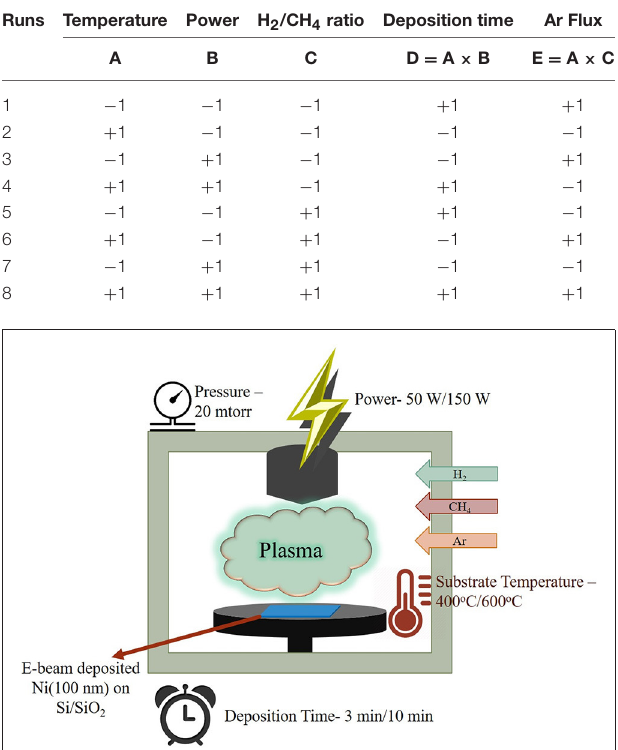
TABLE 3 | Experimental conditions.